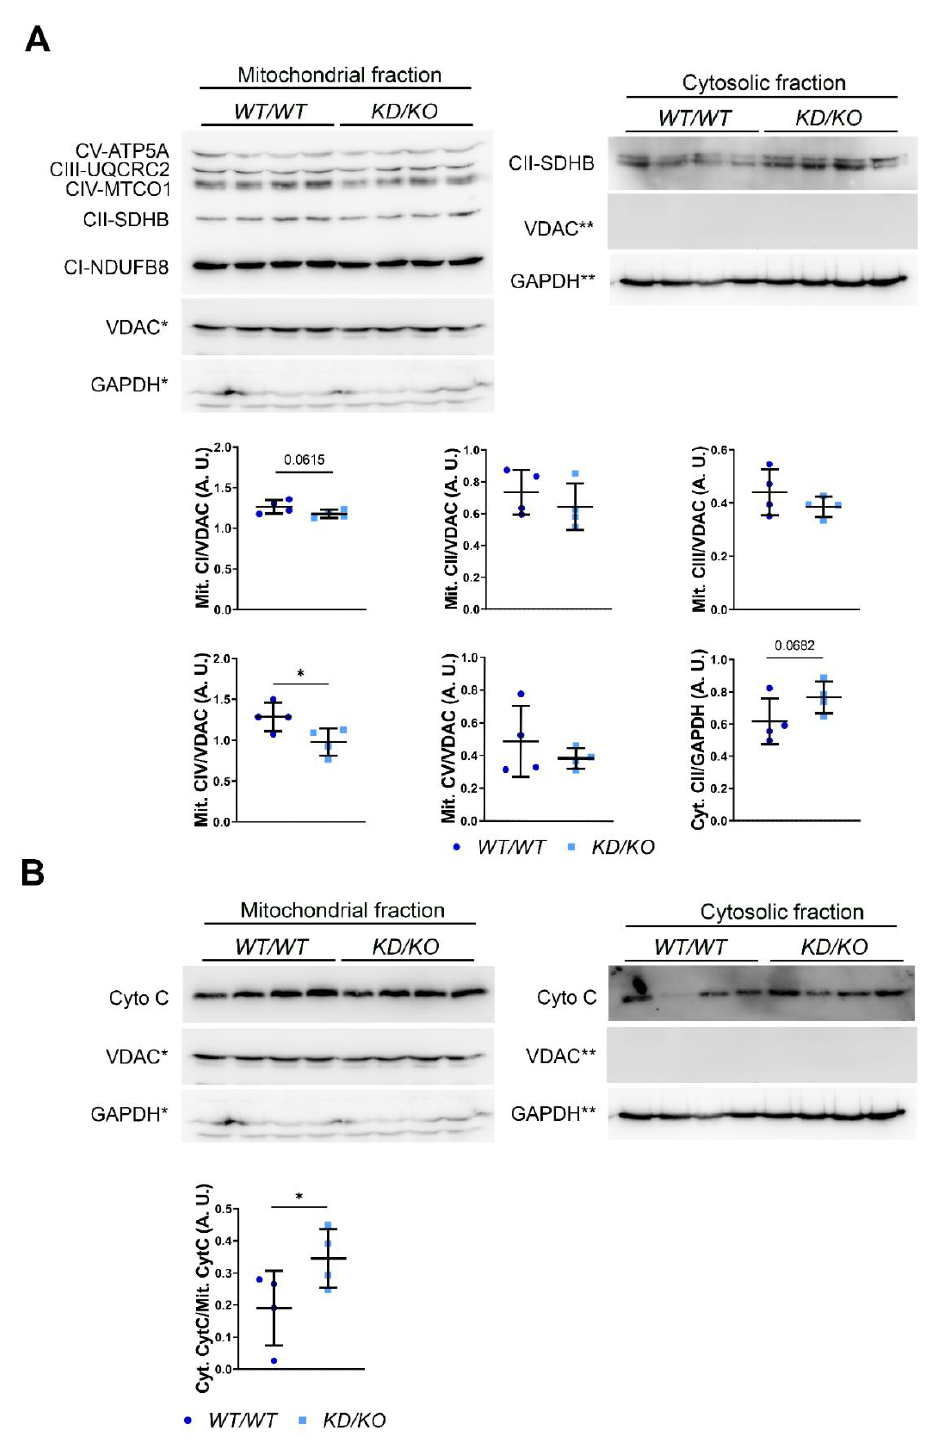
Figure 7. OXPHOS protein content in mitochondrial fraction and cytochrome C release are differentially altered in KD / KO hippocampi . ( A ) Western blot analysis and quantification of OXPHOS proteins in WT / WT and KD / KO cytosolic (Cyt) or mitochondrial fractions (Mit). VDAC and GAPDH are used as both loading and fraction enrichment controls. ( B ) Western blot analysis of cytochrome C in mitochondrial and cytosolic fractions. Note that * or ** in both A and B, indicate that the same control has been used for different quantifications because immunodetections have been performed on the same membrane. Statistical analysis by t -test. n = 4 animals per genotype. *: p -value ≤ 0.5.